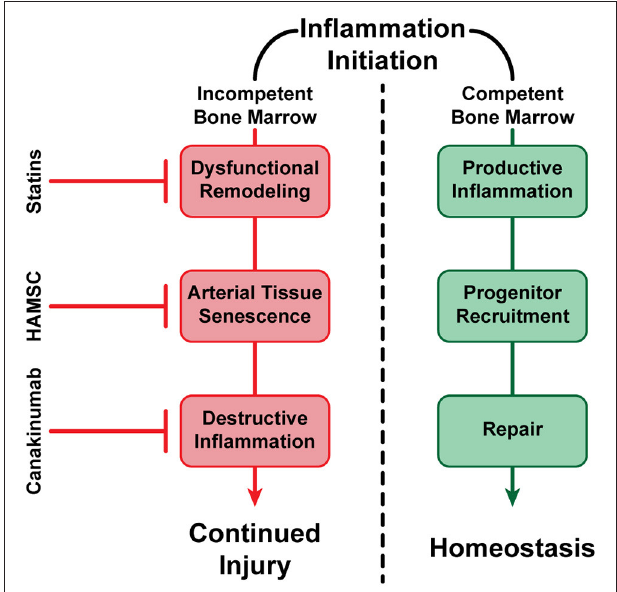
FIGURE 3 | A visualization of alternative fates of vascular inflammation. In the presence of healthy BM-derived vascular progenitor cells capable of arterial repair, inflammation subsides and vanishes (negative feedback loop), resulting in the maintenance of vascular homeostasis. In the absence of sufficient BM-derived vascular progenitor cells, or if such cells are no longer capable of arterial repair, inflammation continues or even expands, resulting in potential dysfunctional remodeling, continued cell senescence, and propagation of arterial injury (positive feedback loop). However, successful treatments have been established such as statin therapy, which has been shown to reduce circulating LDL-Cholesterol (LDL-C), increase HDL-Cholesterol (HDL-C), reducing inflammation and dysfunctional remodeling (Nozue et al., 2013); Human Allogeneic Mesenchymal Stem Cells (HAMSC) (Tompkins et al., 2017), and possibly other progenitor cells (Song et al., 2012), may be able to reverse arterial tissue senescence and improve arterial repair without affecting circulating lipids; and anti-inflammatory molecules such as Canakinumab have also been shown to reduce destructive inflammation without affecting circulating lipids (Ridker et al., 2017). Hence, our armamentarium to prevent, stabilize or even reverse atherosclerosis and its thromboembolic complications are becoming increasingly effective at promoting arterial